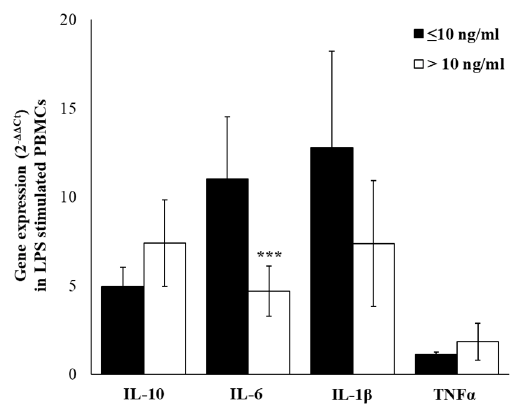
Figure 7. LPS-induced cytokine expression. IL-10, IL-6, IL-1 β , and TNF α levels in LPS-stimulated PBMCs of enrolled workers according to salivary cortisol levels ≤ or > of 10 ng/mL. Data are reported as mean 2 − ∆∆ Ct ± SE. *** p -value ≤ 0.001.